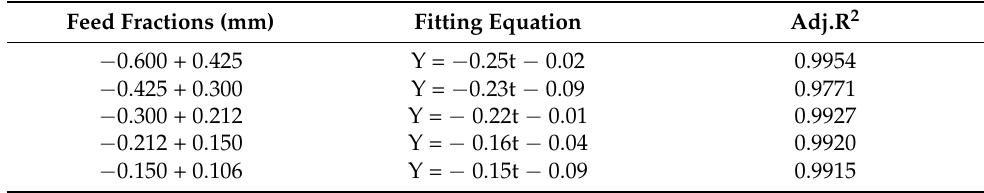
Figure 3. Breakage behavior of magnetite for various feed fractions. Table 3. The operating conditions of the